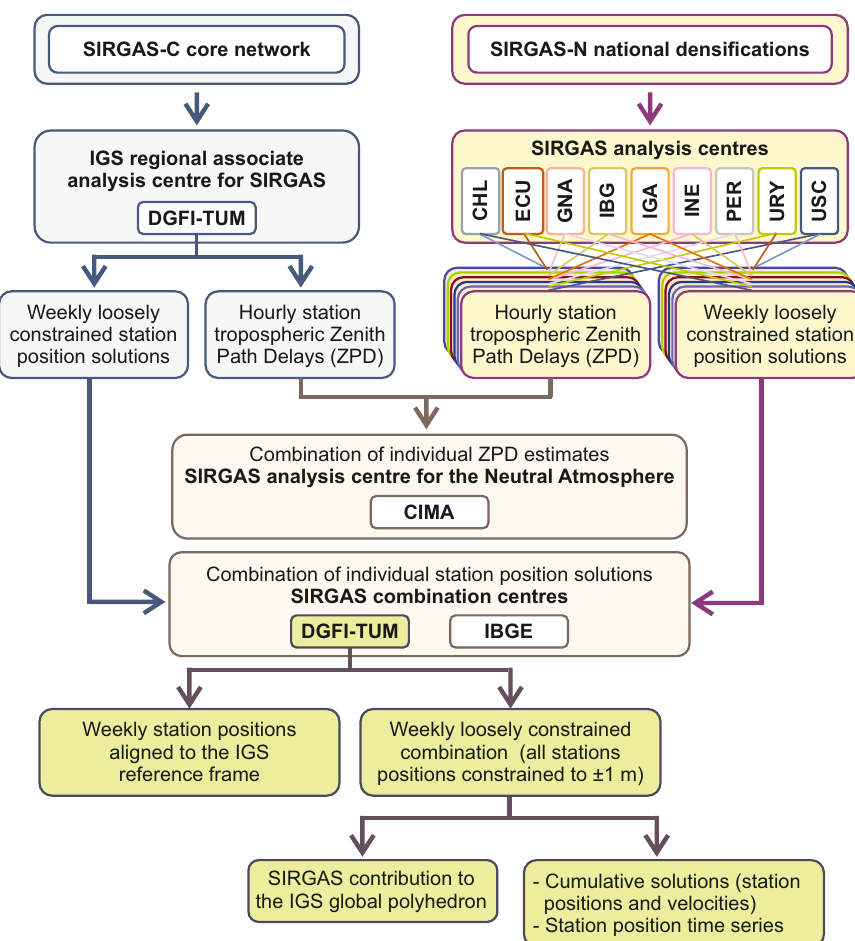
Figure 2: Data fl ow within the weekly analysis of the SIRGAS reference frame ( see Table 1 for more details about the SIRGAS analysis centres )